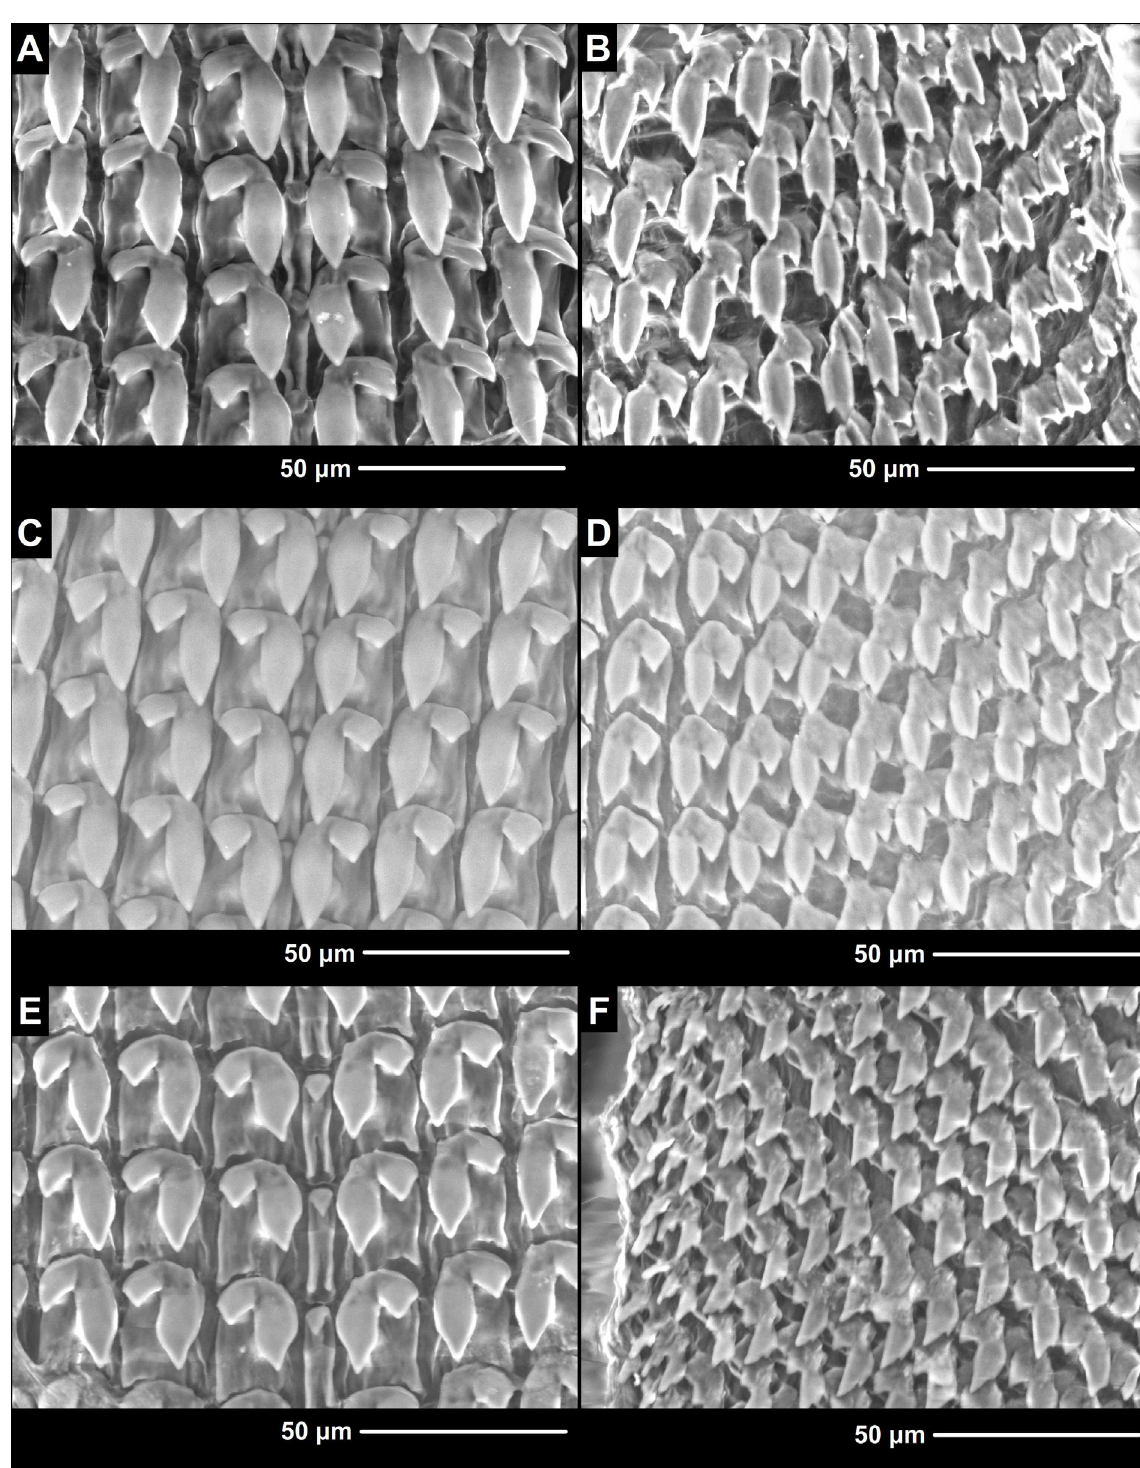
Fig. 16. Radula of species of Chersaecia Gude, 1899. A, C, E . Central and first lateral teeth. B, D, F